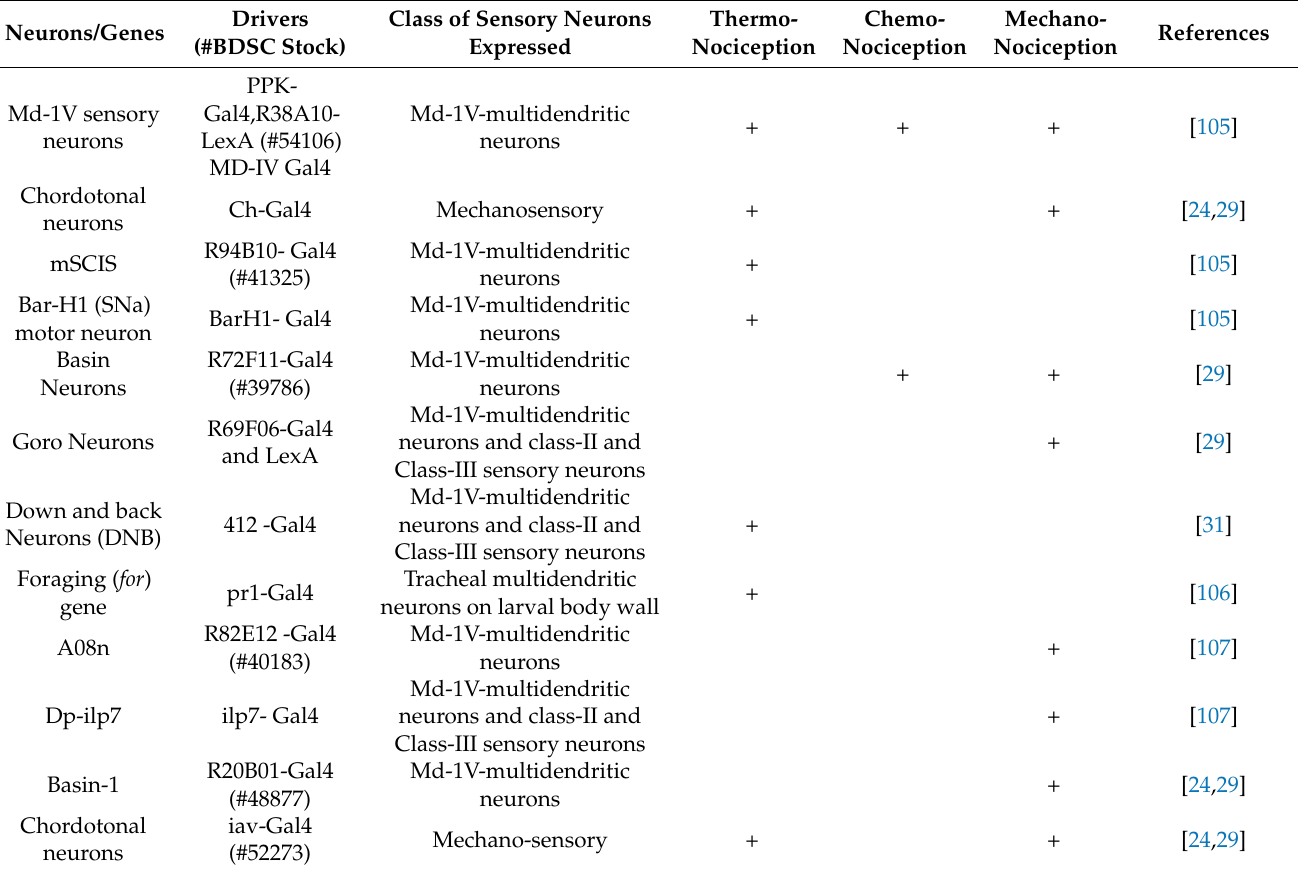
Table 2. List of neurons and their drivers related to sensory locomotion in Drosophila Larvae. Name of neurons/genes, associated Gal4 driver available from Bloomington Drosophila Stock Center (#BDSC), class of sensory neuron, and their associated type of sensory behavior is listed